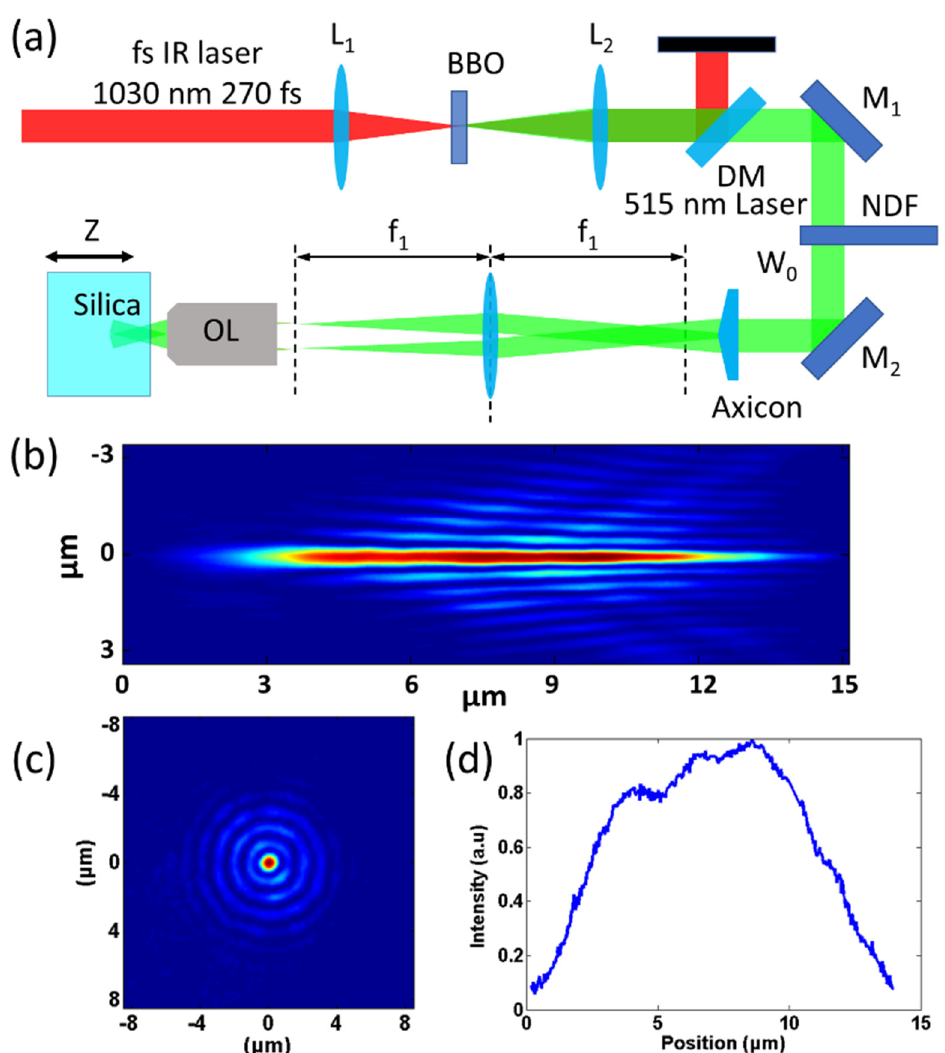
Figure 1. ( a ) schematic diagram of the Bessel beam assisting the nanofabrication system. The BBO generates a 515 nm laser. A dichroic mirror separates the 1030 and 515 nm lasers. An axicon shapes the 515 nm laser beam into the Bessel beam. Long-focal lens and objective project compress the Bessel beam onto the silica sample. L: lens; DM: dichroic mirror; M: mirror; NDF: neutral density filter; OL: objective lens. ( b ) Longitude and ( c ) radial intensity distribution of the Bessel beam. ( d ) The energy distribution of the center spot Bessel beam along the propagation direction.